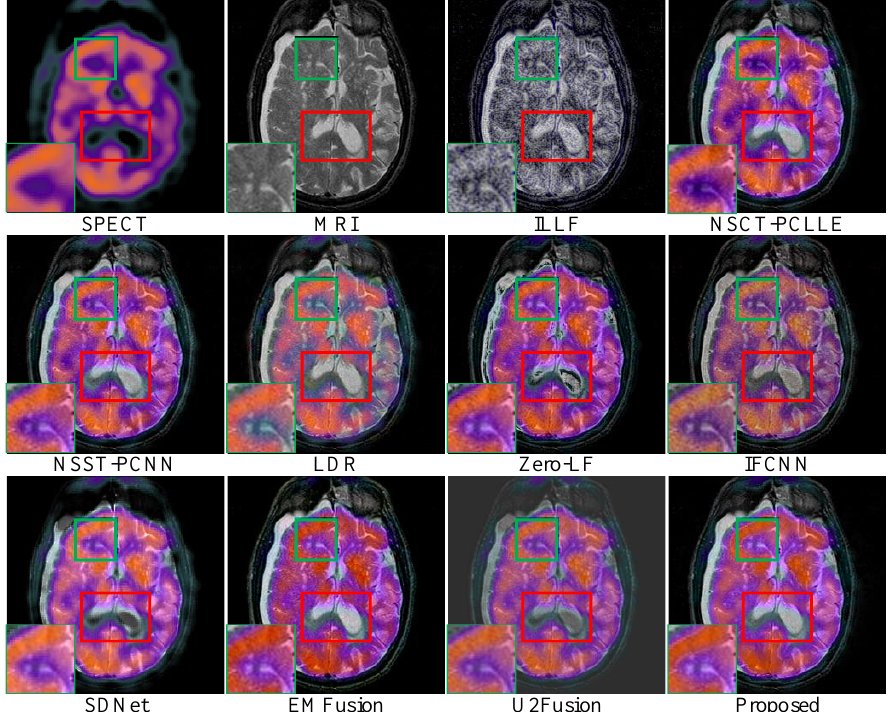
Figure 7. Comparison of performances of various methods on the single-photon emission computed tomography (SPECT)-MRI images. For a clear comparison, we select two same regions (i.e., the green and red boxes) in each image, and the green boxes are zoomed in the bottom left corner .